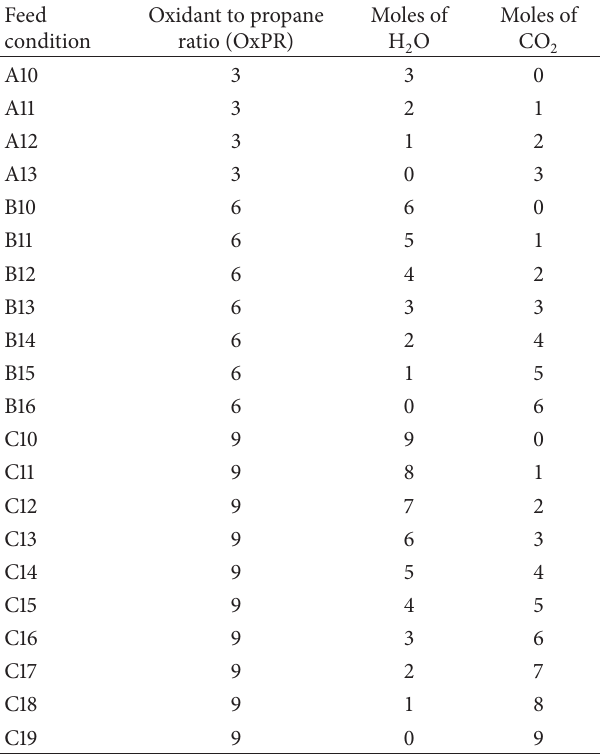
Table 1: Input feed conditions for different (OxPRs) oxidant to feed